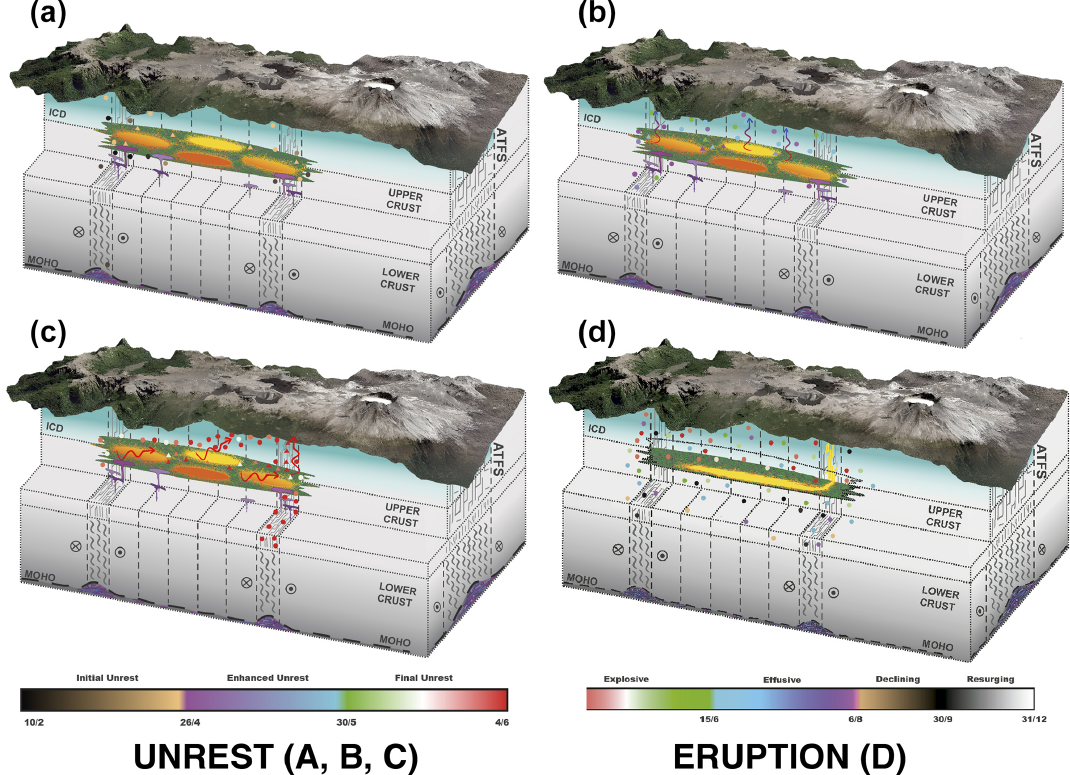
Figure 10. Evolution of the magmatic plumbing system and seismicity before (a, b, c) and after (d) the eruption onset. Circles and triangles are, respectively, VT and HB seismic events. They are colored as in Figs. 5–8. Undulated arrows mark the pattern of fluid and magma